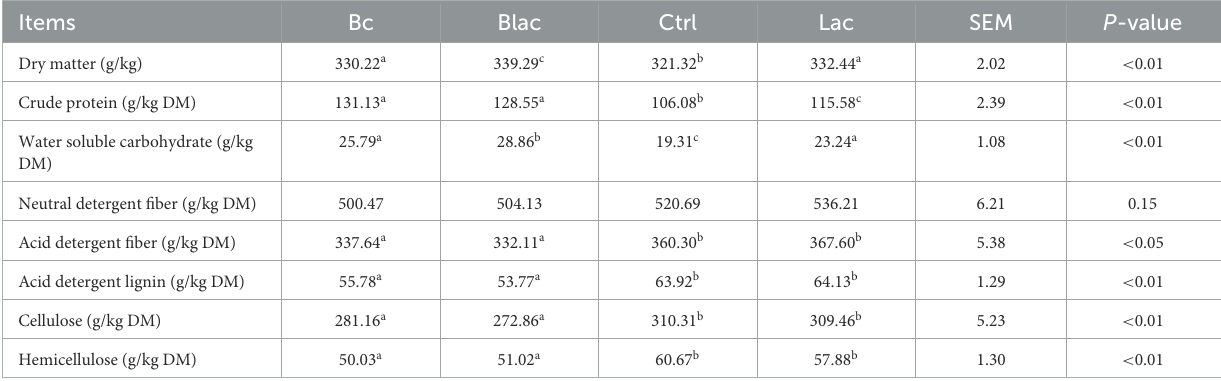
TABLE 4 Chemical composition of rape silage after 60 days ensiling.